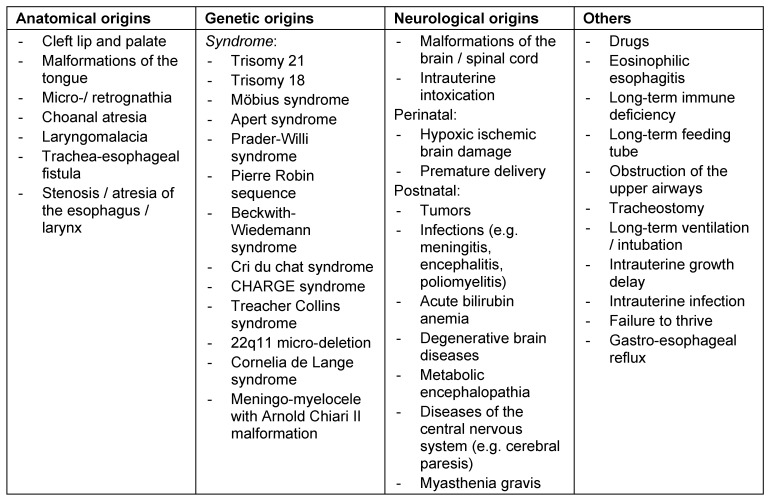
Different origins of pediatric swallowing disorders (modified according to Kühn [80] and Biber [276])